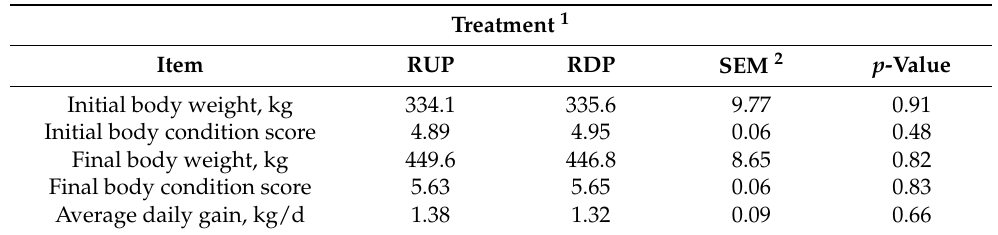
Table 5. Performance parameters of yearling heifers supplemented with rumen undegradable or degradable protein while grazing improved dryland pastures.